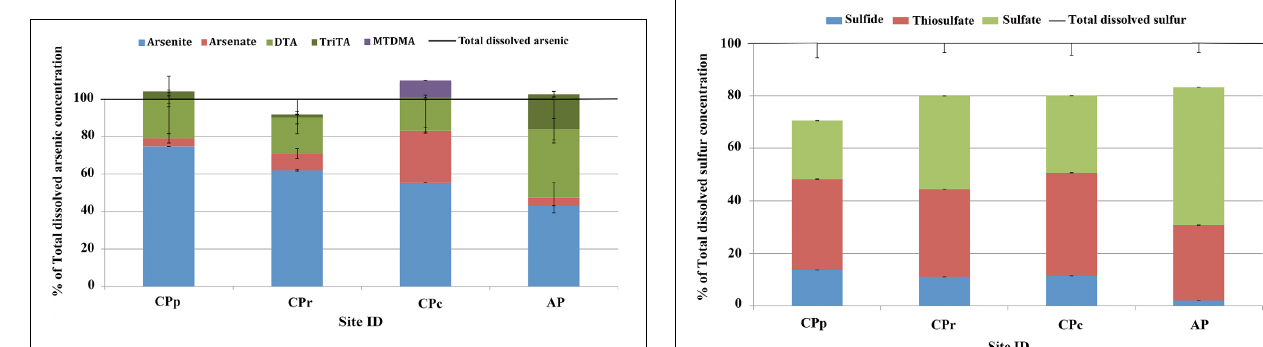
FIGURE 3 | Sulfur speciation as a percentage of total dissolved sulfur concentration at Champagne Pool. CPp, central pool; CPr, rim of pool; CPc, outflow channel; AP, “Artist’s Palette” terrace.